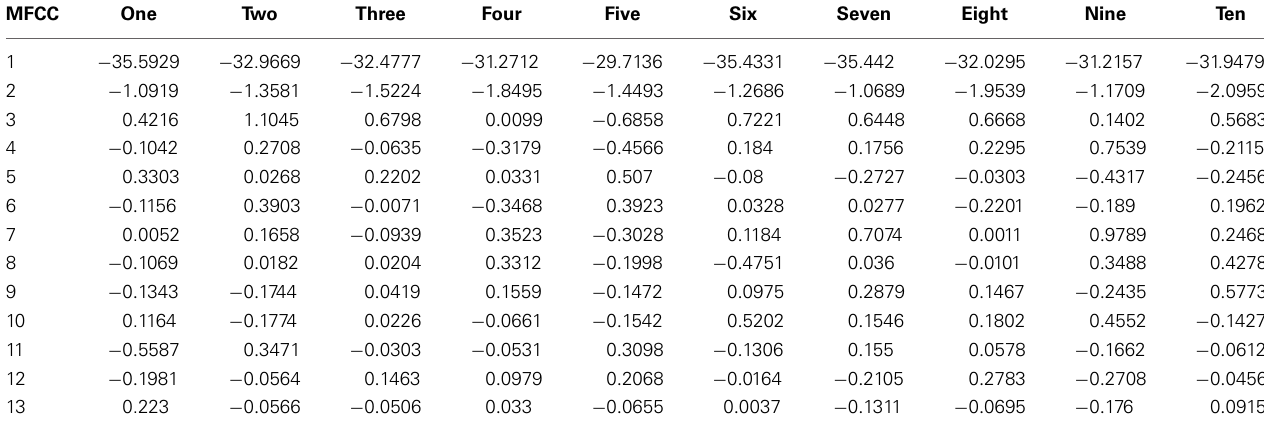
Table 2 | Mel Frequency Cepstral Coefficients for number